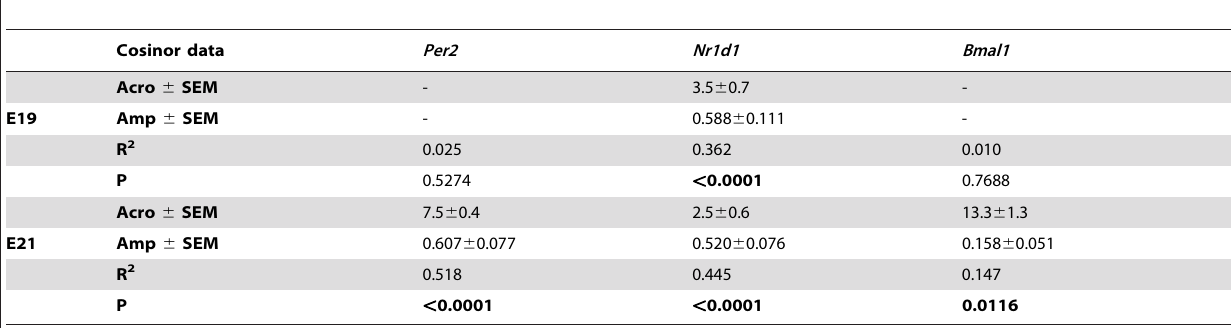
Table 1. Cosinor analysis of expression profiles of clock gene Per2 , Nr1d1 and Bmal1 in the SCN of fetuses at E19 and E21.